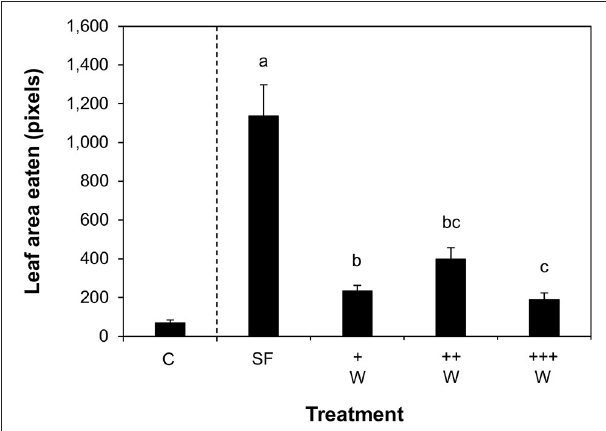
FIGURE 3 | Damage inflicted by Spodoptera frugiperda larvae. Average amount of damage inflicted ( + SE) on teosinte plants in tents that were not infested with herbivores (treatment C) or that were infested with larvae in the absence (SF) and in the presence of increasing densities of Campoletis sonorensis parasitoid wasps ( + W, ++ W, + + + W). Different letters indicate statistically significant differences (GLM, P < 0.05). Only plots where larvae were released were included in the statistical analyses.